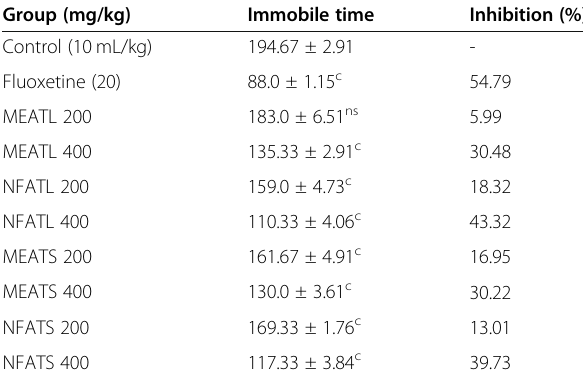
Table 3 Antidepressant activity of different extracts of A. trilobata on forced swimming test in mice